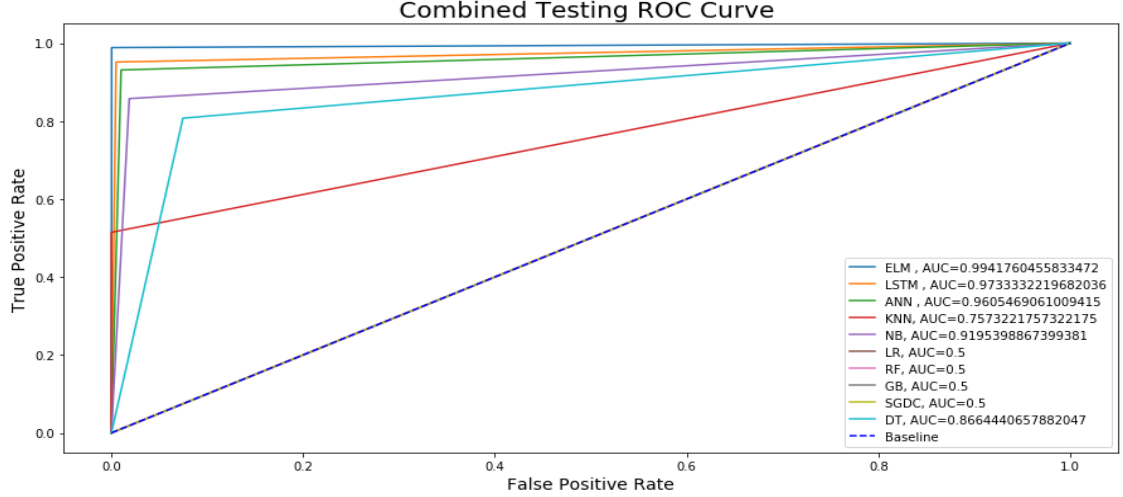
Figure 14. ROC Curve for Testing Comparison of Epileptic Activities Recognition.